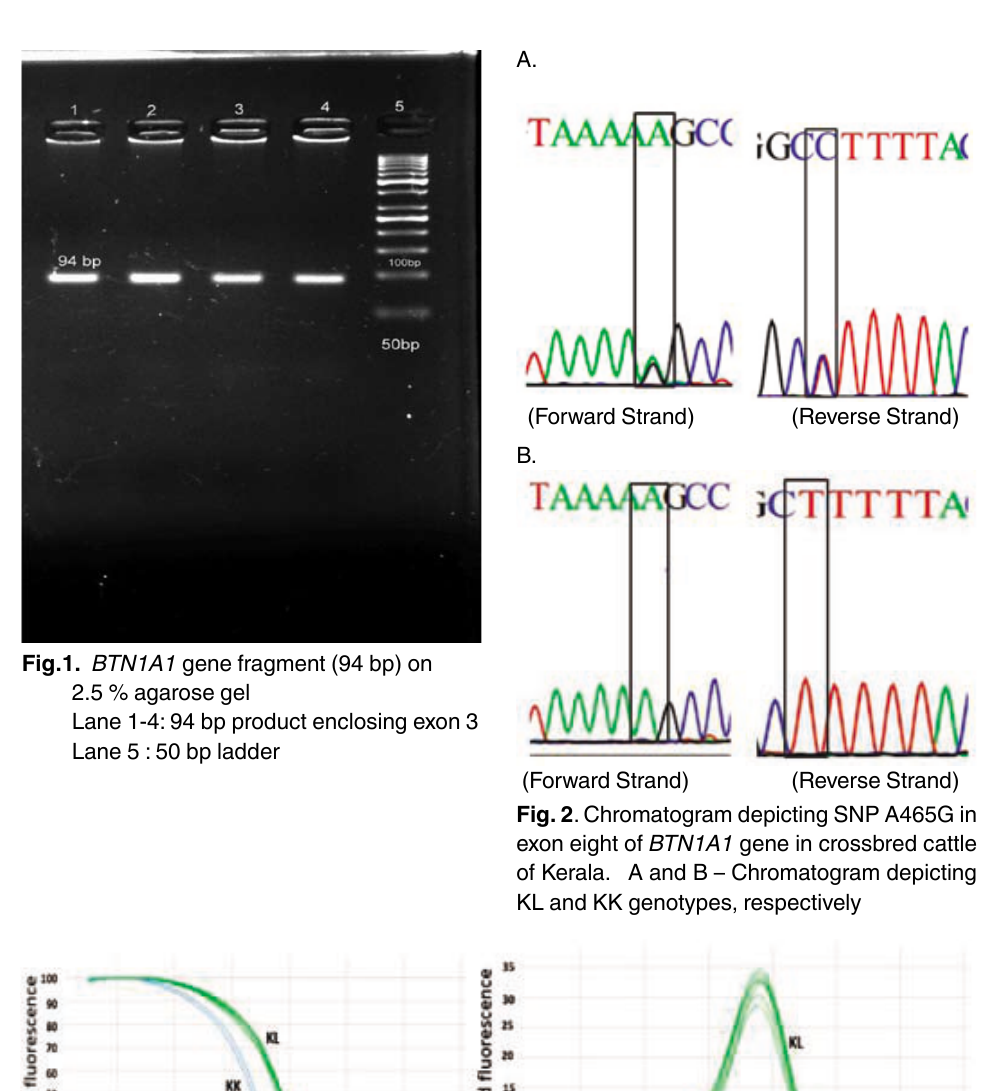
Fig. 3 . Normalised and difference melt curve of polymorphism A465G representing two different curve patterns for genotypes KK (blue) and KL (green), respectively.